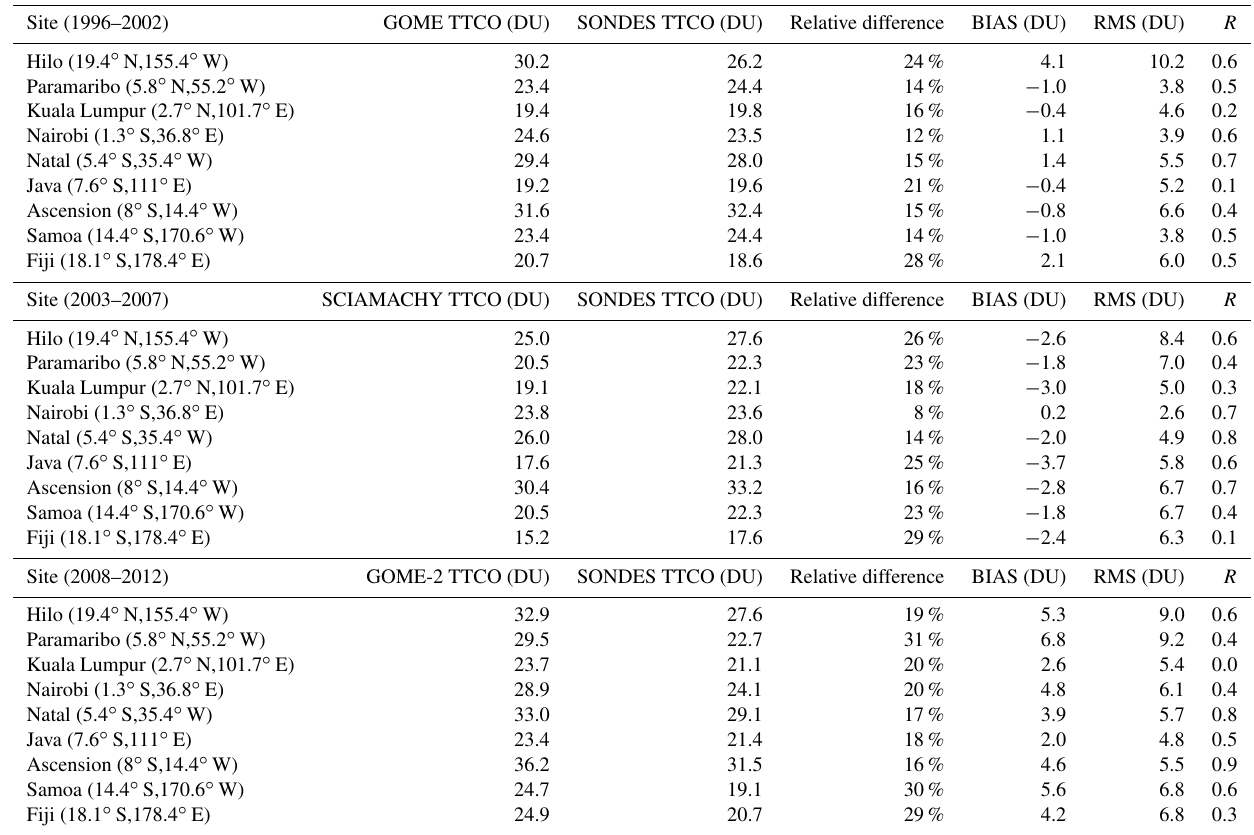
Table 2. Statistical comparison between GOME, SCIAMACHY, and GOME-2 TTCO with ozonesondes for nine SHADOZ sites. Information presented here are the ozonesonde site, the mean TTCO for GOME/SCIAMACHY and for ozonesondes, the relative difference, the bias, and the RMS difference between CCD TTCO and sondes and finally the correlation